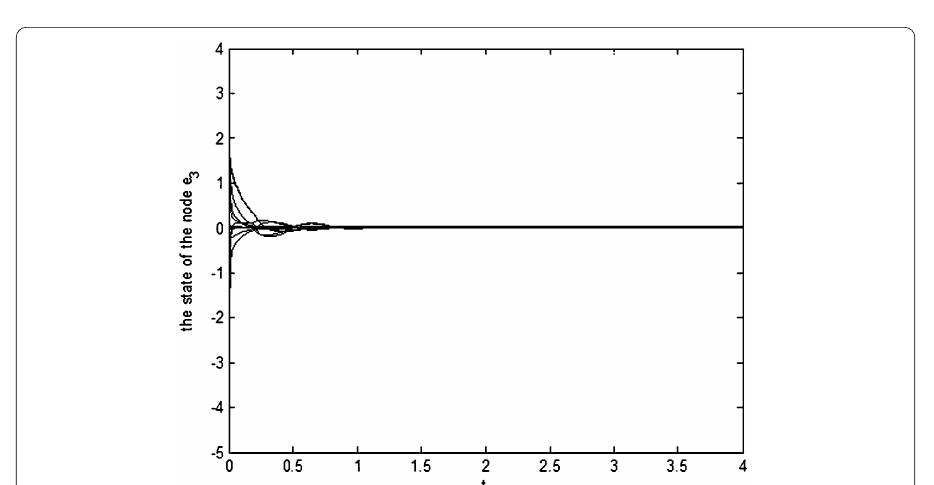
Figure 6 The state of the node e 3 with